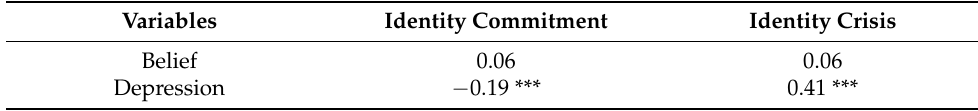
Table 4. Inter-correlations among study scales ( N =